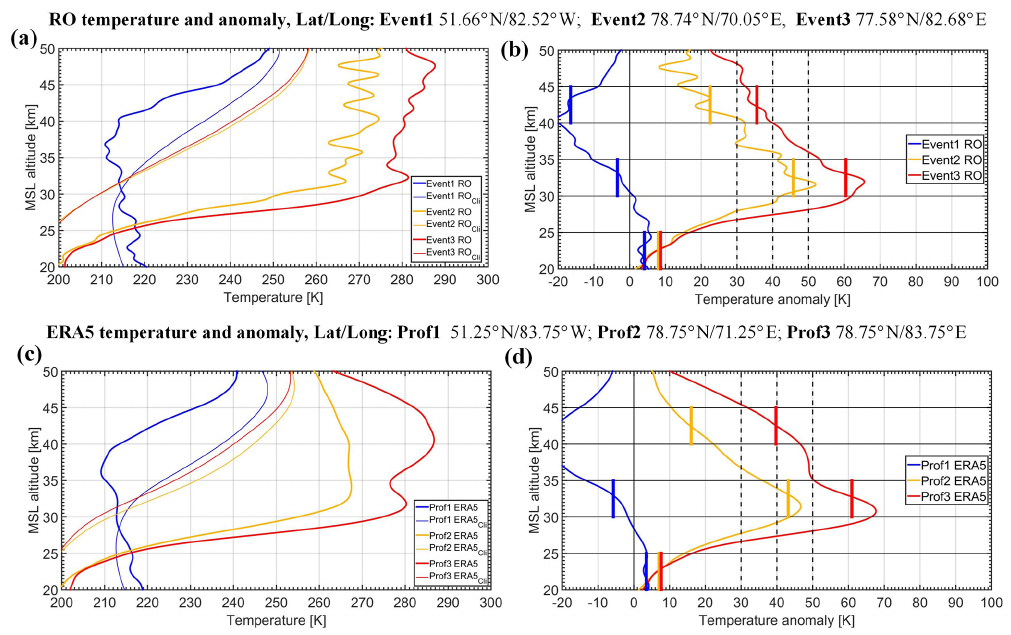
Figure 3. Illustration of anomaly construction, layer selection, and computation of layer-mean anomaly values based on the three example RO events and ERA5 profiles indicated in Fig. 1b and d. (a) Event 1 to 3 temperature profiles from RO and collocated climatological pro- files RO Cli ; (b) RO temperature anomaly profiles from the difference of RO to RO Cli profiles as well as indication of the lower-stratosphere (20–25km), middle-stratosphere (30–35km), and upper-stratosphere (40–45km) layers and associated layer-mean anomaly values; (c) Pro- file 1 to 3 temperature and corresponding climatological profiles from ERA5 in same style as (a) ; (d) ERA5 temperature anomaly profiles and layer-mean values in the same style as (b) . The RO satellites and event times and the ERA5 analysis time layers of these examples are as follows (for the locations, see the panel headers): Event1 – COSMIC-FM1 event on 1 January 2007 at 04:28UTC; Event2 – COSMIC-FM1 event on 1 January 2007 at 22:44UTC; Event3 – MetOp-A event on 25 December 2018 at 17:04UTC; Prof1 – ERA5 profile for 1 Jan- uary 2007 at 06:00UTC; Prof2 – ERA5 profile for 2 January 2007 at 00:00UTC; Prof3 – ERA5 profile for 25 December 2018 at 18:00UTC. The climatological profiles are extracted (and interpolated to the needed locations and times) from long-term-averaged (2006–2020 for RO and 1979–2020 for ERA5) monthly mean 2 . 5 ◦ × 2 . 5 ◦ temperature